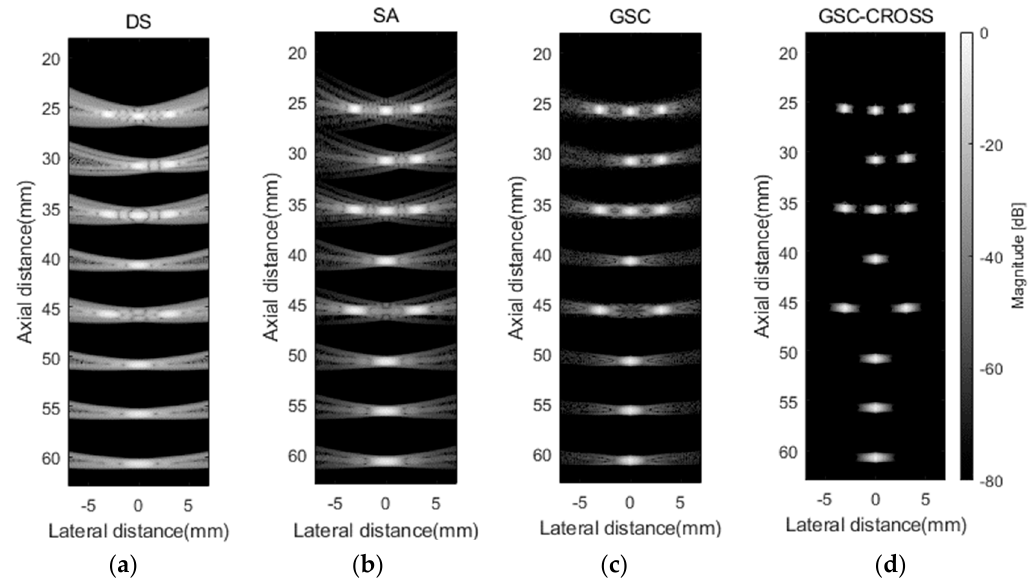
Figure 3. Beamforming responses of simulated point targets with different algorithms. ( a ) DS; ( b ) SA; ( c ) GSC (L = 32, Δ = 10); ( d ) GSC-CROSS (L = 32, Δ = 10). The dynamic range of image is 80 dB. Table 1. FWHM and PSL of point targets at depth z = 40